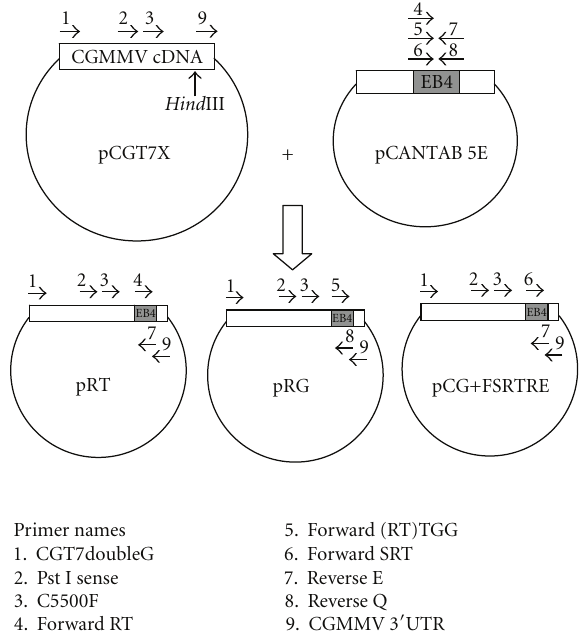
Figure 1: Position of primers in constructed plasmid clones. Primers 4–8 were used to amplify the EB4 gene from pCANTAB 5E. Plasmid pCGT7X and amplified EB4 fragments were digested with Hin dIII and ligated together to obtain the respective plasmid clones as shown. Hin dIII is the insertion site of EB4 at the end of CGMMV CP. PCR amplification using primer pairs 1–9, 3–9, and 2–7 will yield amplified products of approximately 6.5kb, 0.85 kb, and 2.2 kb,